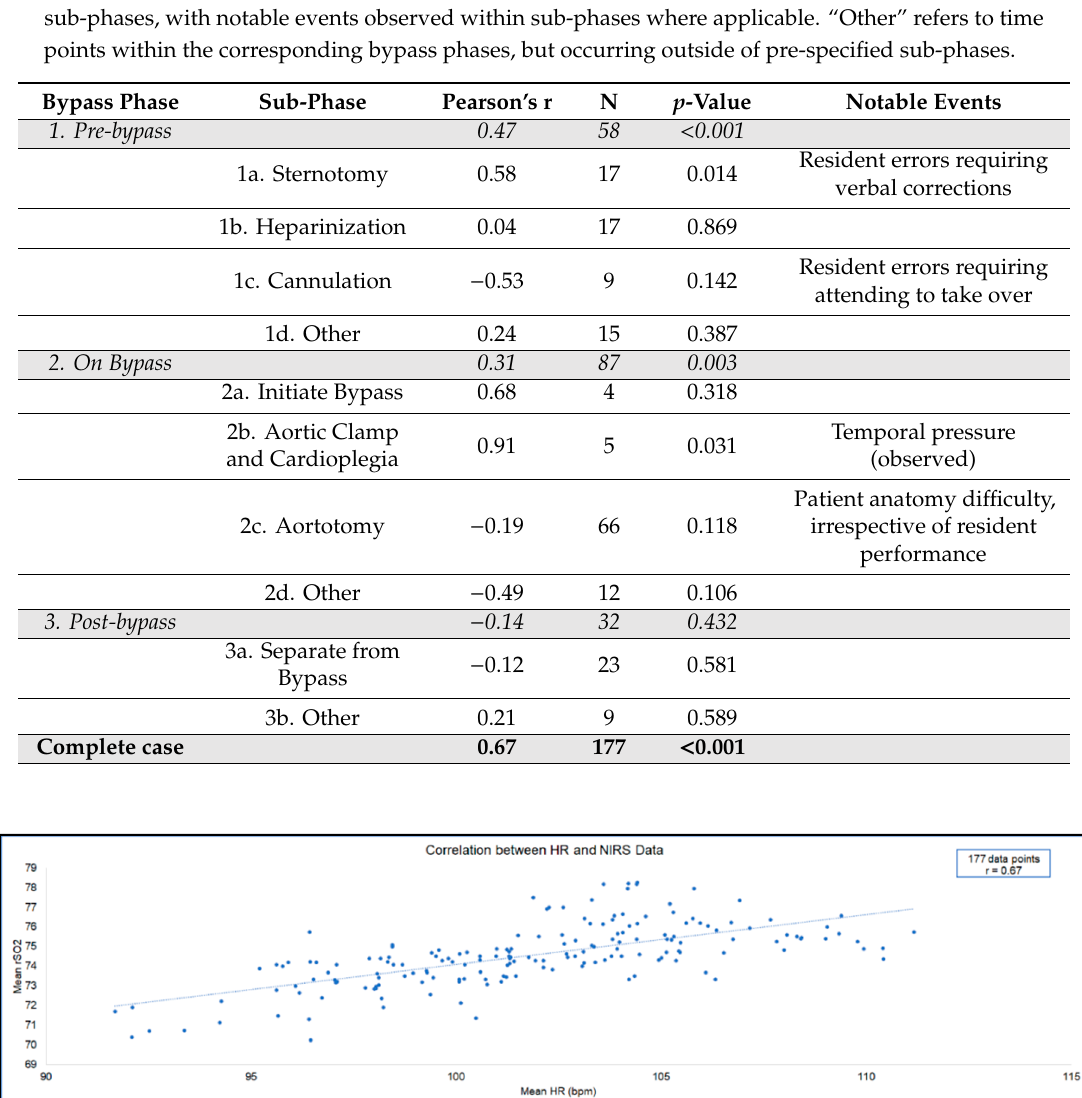
Table 1. Pearson’s r correlations between mean HR and mean rSO 2 values for bypass phases and sub-phases, with notable events observed within sub-phases where applicable. “Other” refers to time points within the corresponding bypass phases, but occurring outside of pre-specified sub-phases.